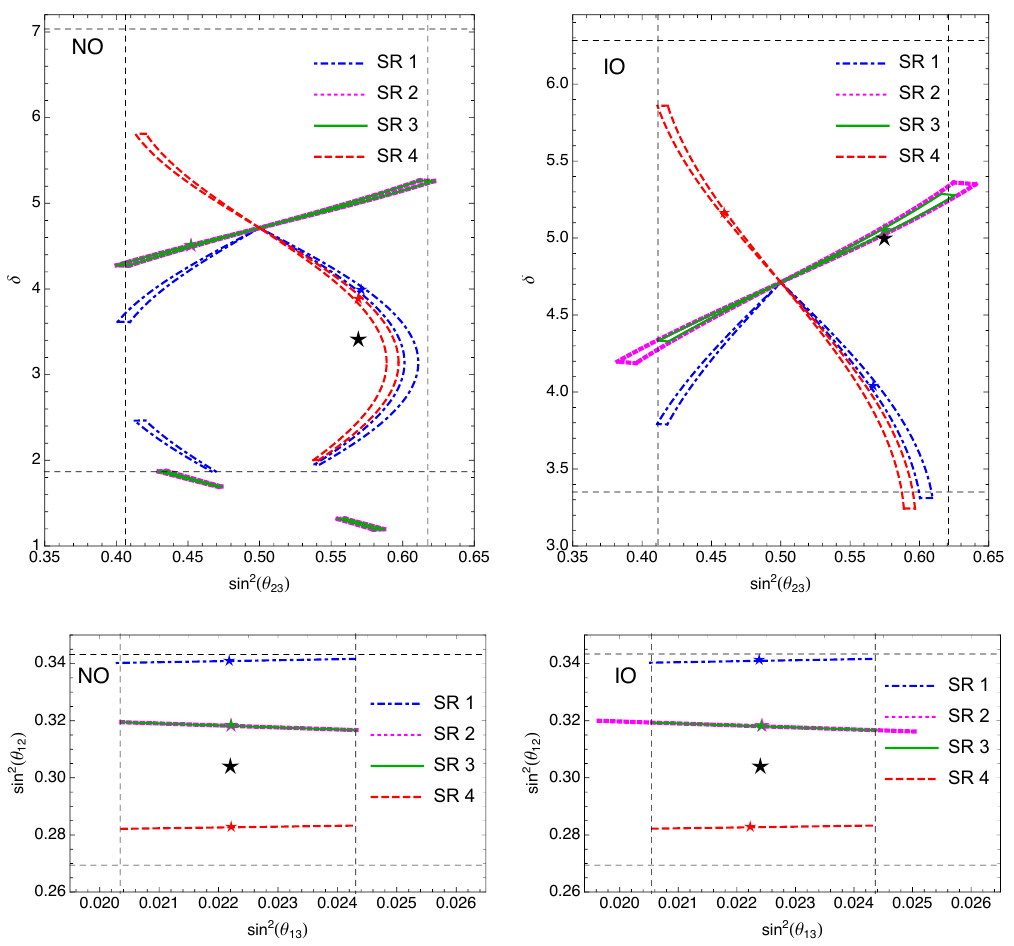
Figure 5 . Allowed ranges for the mixing parameters for all sum rules using θ, φ in their 3 σ ranges. The black dashed lines show the 3 σ allowed region without sum rules for NO/IO. The coloured (black) stars shows the best fits with (without) sum